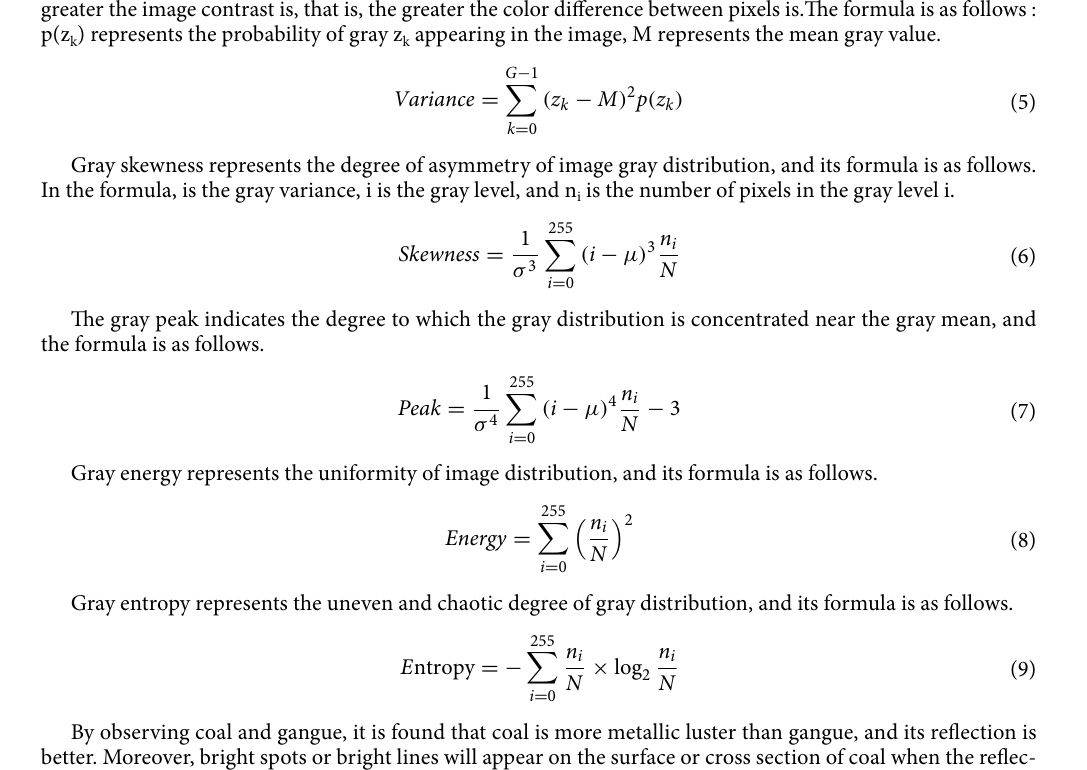
Gray variance represents the dispersion degree of gray value. Visually, the larger the gray variance is, the greater the image contrast is, that is, the greater the color difference between pixels is.The formula is as follows : p(z k ) represents the probability of gray z k appearing in the image, M represents the mean gray value.